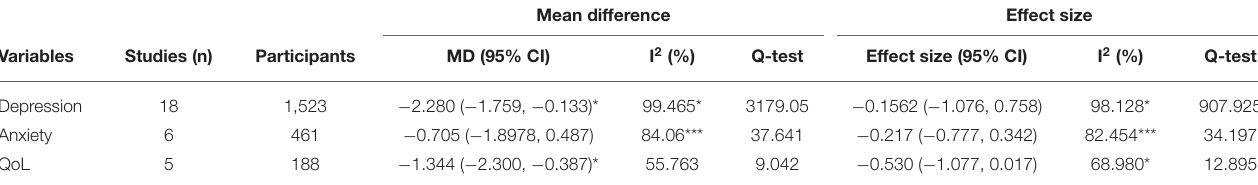
TABLE 2 | Standardized mean difference and effect size of polyphenol intervention on depression, anxiety and QoL.